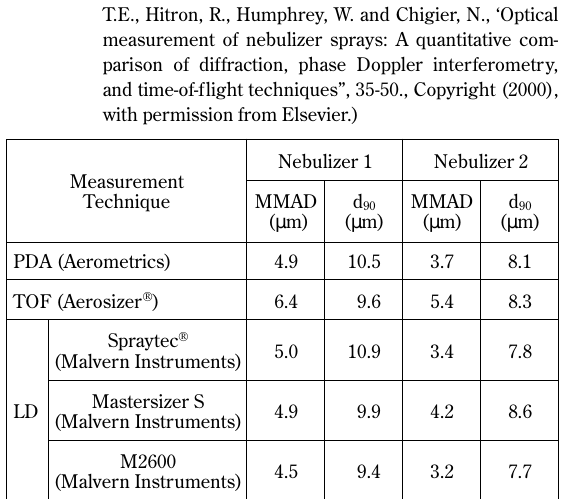
unrepresentatively sampled. LD and PDA methods do Table 15 Comparison of MMAD and Size Corresponding to 90 th